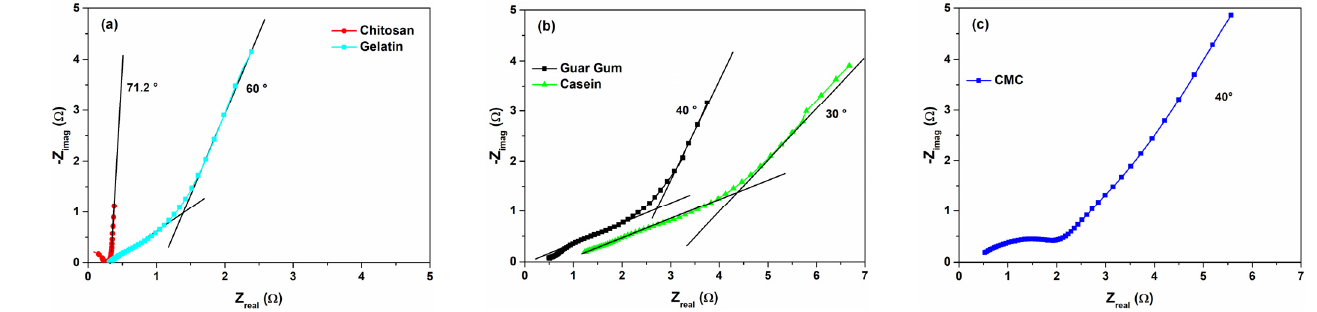
Figure 9. Comparative Nyquist plots for the SCs with ( a ) chitosan, gelatin, ( b ) guar gum, casein, and ( c ) CMC as the electrode material binder in the fresh state. ( c ) CMC as the electrode material binder in the fresh